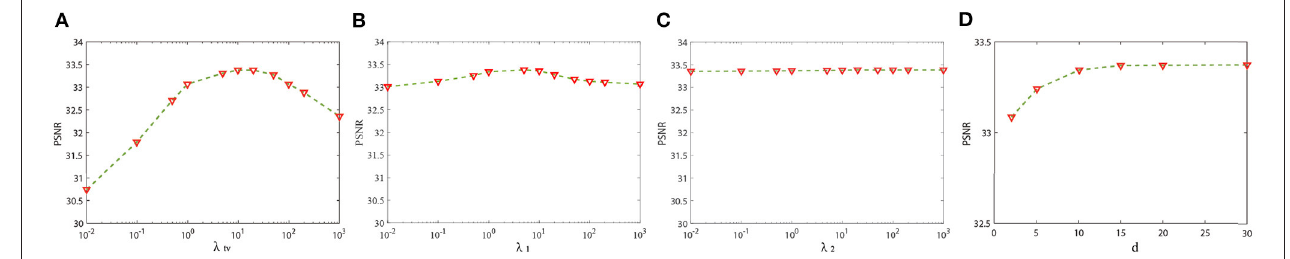
FIGURE 2 | Sensitivity analysis of two regularization parameters: (A) The peak signal-to-noise ratio (PSNR) value vs. λ tv ; (B) the PSNR value vs. λ 1 ; (C) the PSNR value vs. λ 2 ; (D) the PSNR value vs. the number of similar patches.